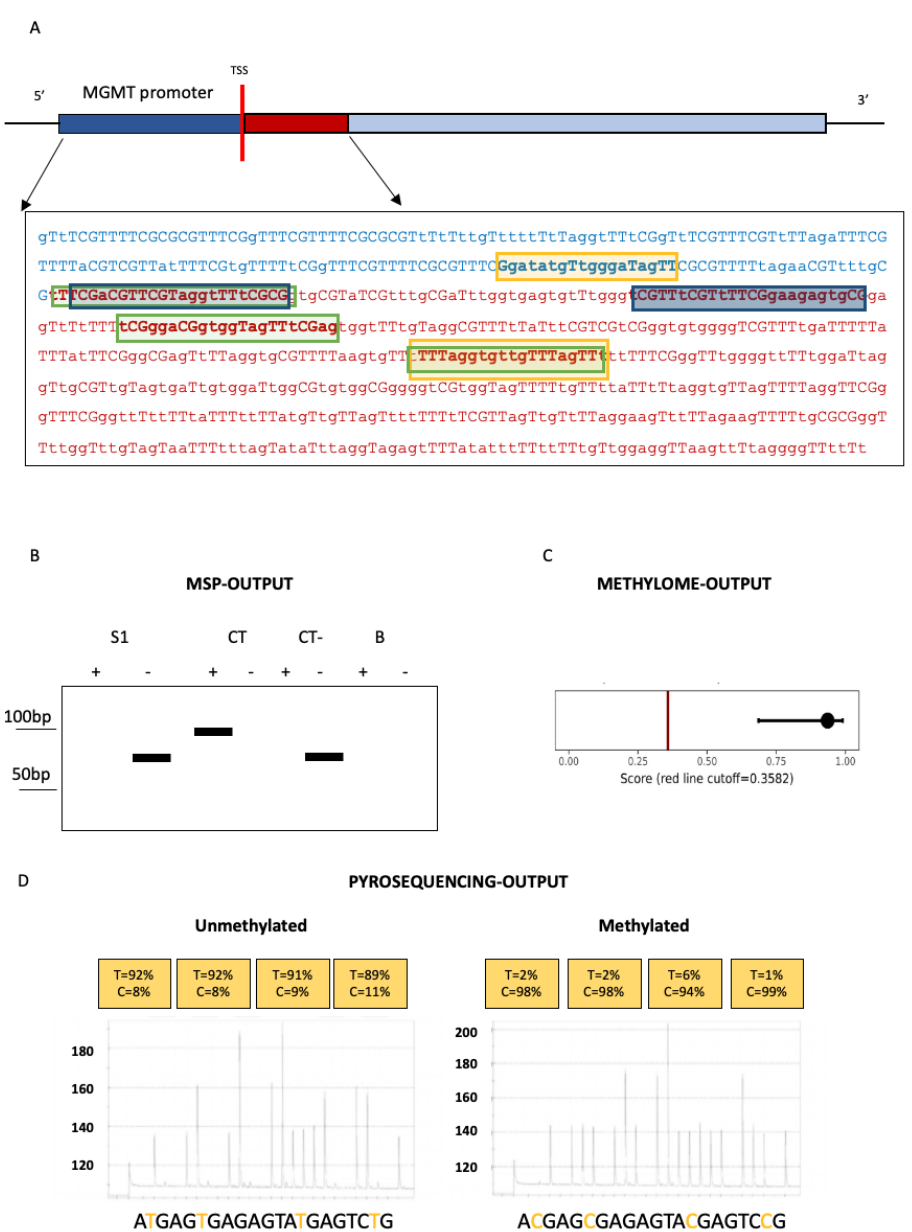
Figure 2. Graphic representation of MGMT gene regulatory region and output of the technologies used to analyze MGMT methylation after sodium bisulfite conversion. ( A ) MGMT gene promoter (blue) and exon 1 (red) are represented. Focus on bisulfite-converted sequence analyzed by different techniques: in yellow rectangles, primers used to perform pyrosequencing; in blue rectangles, primers used in methylation-specific PCR (MSP); in green rectangles, primers used in real-time PCR. ( B ) Graphical representation of MSP output: a glioblastoma sample (S1), an internal methylated (CT) and a non-methylated (CT-) controls, and a control without DNA (B) are depicted, each including a lane signed with «+» (methylated DNA specific primers) and a lane signed with « − » (un-methylated DNA specific primers). ( C ) Graph indicating MGMT methylation status predicted by methylome analysis. ( D ) Capillary electrophoresis indicating output of pyrosequencing analysis of MGMT promoter methylation in 2 glioblastoma